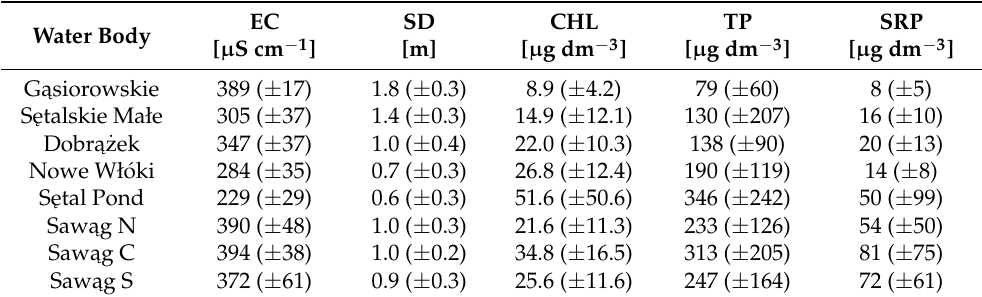
Table 2. Indicators of trophic status of analysed water bodies measured in growing seasons (April– October) of 2009–2013: mean values and standard deviation (abbreviations: EC—specific electrolytic conductivity; SD—Secchi depth; CHL—chlorophyll concentration; TP—total phosphorus concentra- tion; SRP—soluble reactive phosphorus concentration).